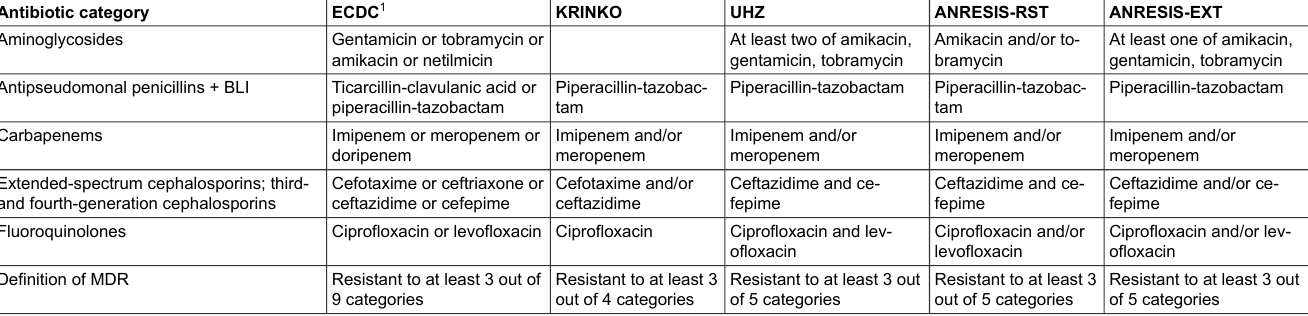
Table 3: Definition criteria and antibiotic panel for Acinetobacter